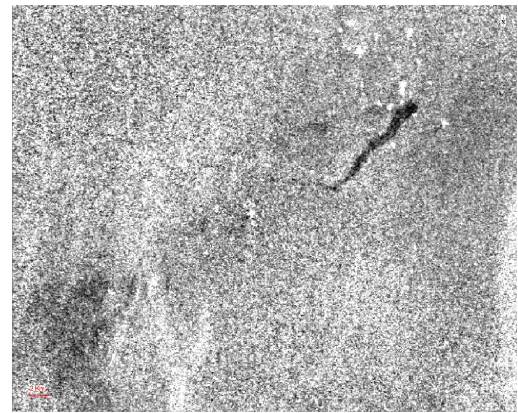
Figure 5f. ENVISAT WSM SAR image taken on the 30 th October 2011on same area as Fig. 5a